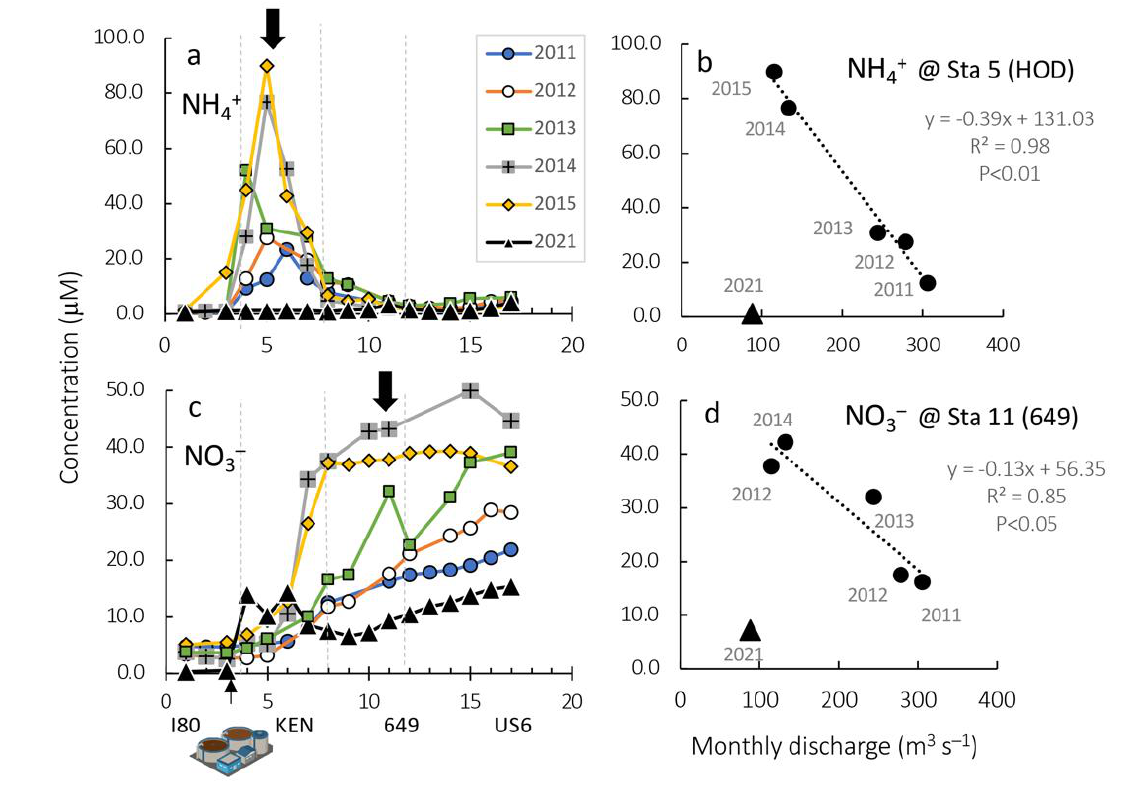
Figure 4. Transects of NH 4+ (panel a ), and NO 3 − (panel c ) for the six years of sampling undertaken in the Bay Delta during September/October. Sampling in 2021 was 5 months after full implementation of the upgraded WWTP. Vertical dashed lines separate the major segments of the river/estuary. The WWTP icon shows location of discharge. Correlations of average monthly discharge and NH 4+ concentrations at station 5 (HOD), and NO 3 − concentrations at station 11 (649), are shown in (panels b , d ), respectively. Note the stations for which relationships with discharge are shown are highlighted by black arrows in (panels a , c ). The 2021 data (highlighted as triangles) are not included in the regressions.